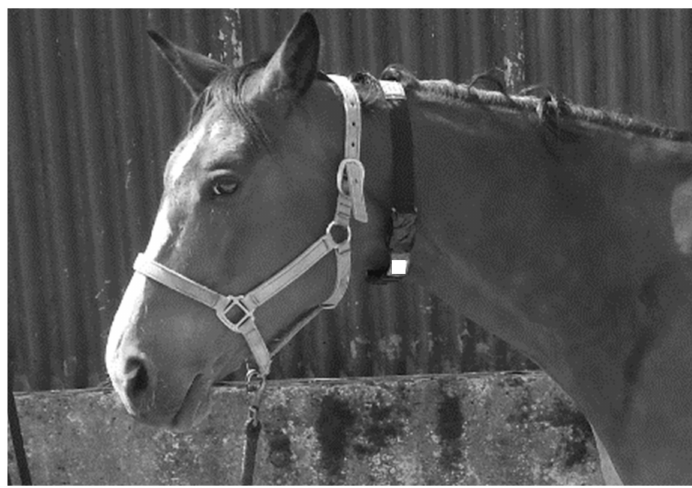
Figure 2. Bay horse with safety collar and attached data